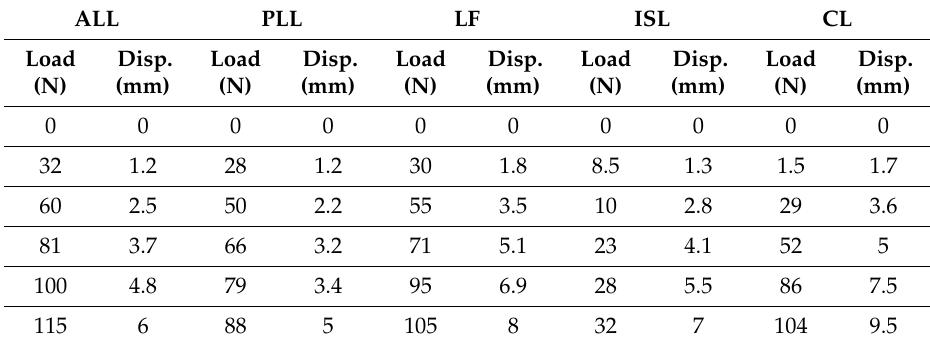
Table 1. The nonlinear material properties of the ligaments used in the Finite Element model [10]. ALL PLL LF ISL CL Load Load Disp.